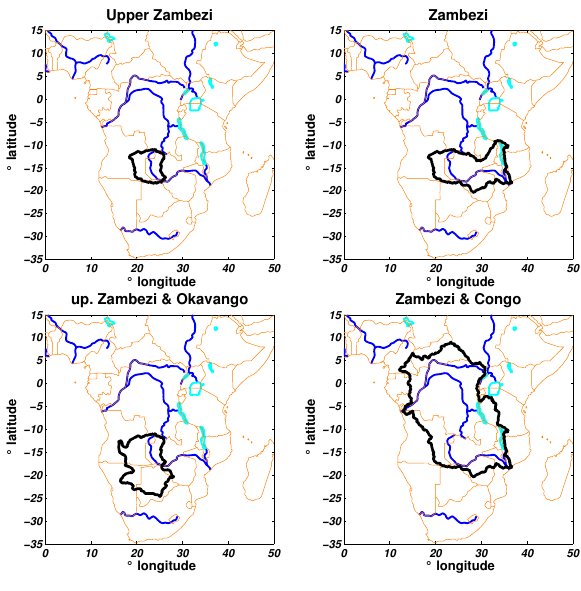
Fig. 3. The four target areas being used in this study (from left to right, from top to bottom): upper Zambezi, Zambezi, upper Zam- bezi + Okavango, and Zambezi + Congo.